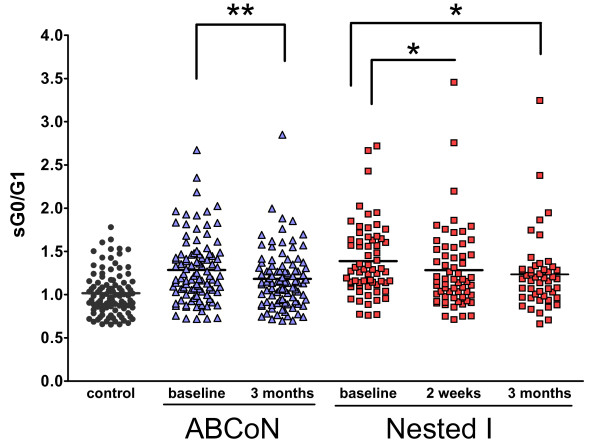
Ratio of agalactosylated to monogalactosylated N-glycans in serum immunoglobulin (sIgG0/G1) is elevated at baseline and improves with treatment. Data show sG0/G1 from baseline and follow-up visits in both cohorts. All rheumatoid arthritis time points P < 0.001 vs healthy controls. P-values were derived from paired t-tests (*P < 0.05; **P = 0.01). Paired data available for Autoimmune Biomarkers Collaborative Network were n = 75 vs 3 months; Nested I, n = 61 vs 2 weeks and n = 48 vs 3 months.